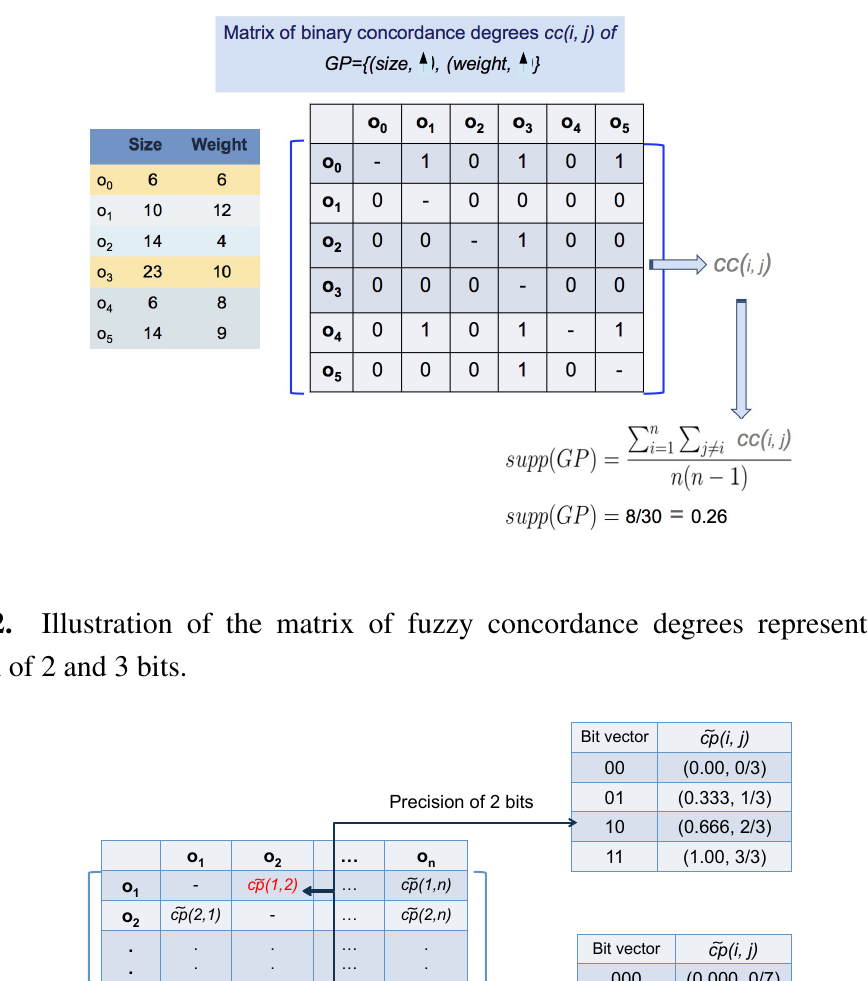
Figure 1. Illustration of the binary matrix of concordant couple and computing of support.